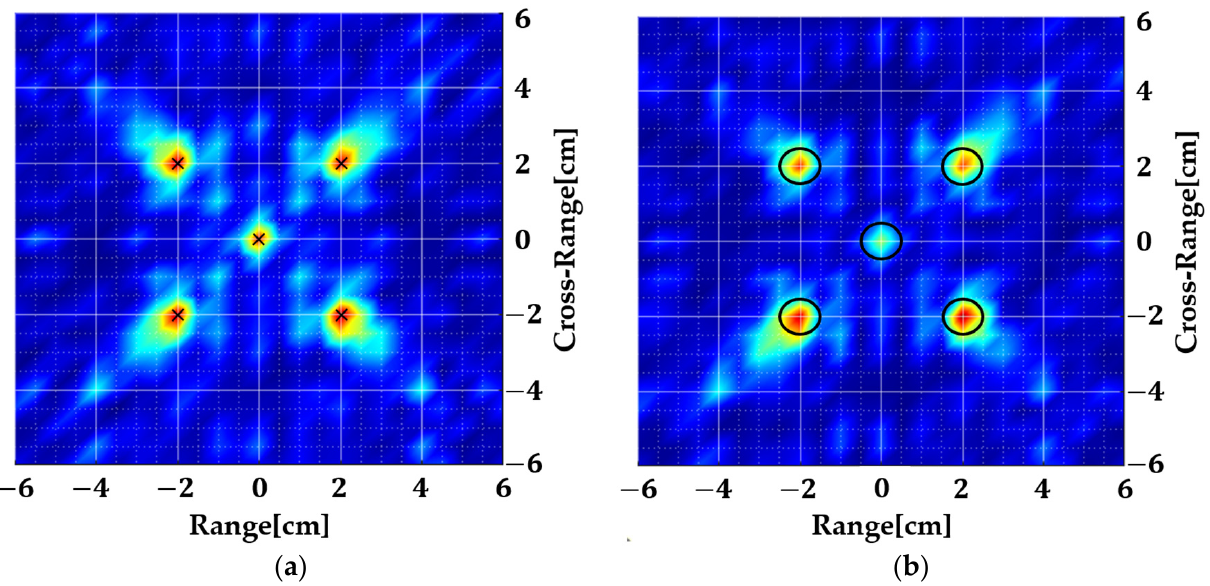
Figure 5. Near ‐ field ISAR images of the geometry shown in Figure 3 by pre ‐ processing using Equa ‐ Figure 5. Near-field ISAR images of the geometry shown in Figure 3 by pre-processing using tion (12) and using only the first exponential term. ( a ) 𝑅 (cid:3042) (cid:3404) 6 cm ( b ) 𝑅 (cid:3042) (cid:3404) 7 cm with target diame ‐ Equation (12) and using only the first exponential term. ( a ) R o = 6 cm ( b ) R o = 7 cm with target ter changed to 1 cm. The method works with changing target size and array radius. diameter changed to 1 cm. The method works with changing target size and array